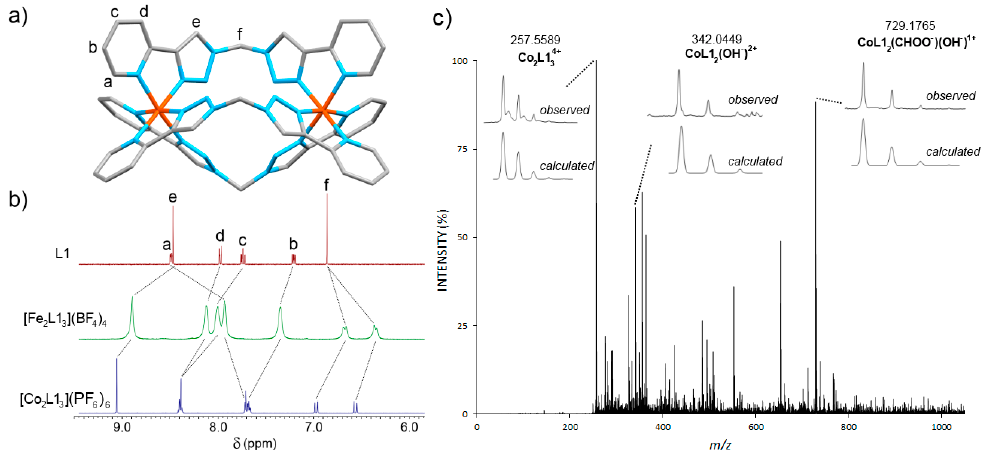
Figure 1. ( a ) Crystal structure of [Fe 2 L1 3 ](BF 4 ) 4 (hydrogen atoms, solvent molecules, and counter-ions have been omitted for clarity) Colours: carbon = grey; nitrogen = blue; iron = orange; ( b ) partial stacked 1 H-NMR spectra (400 MHz, 298 K, CD 3 CN) of L1 , [Fe 2 L1 3 ](BF 4 ) 4 and [Co 2 L1 3 ](PF 6 ) 6 ; ( c ) representative mass spectrum of [Co 2 L1 3 ](OTf) 6 .